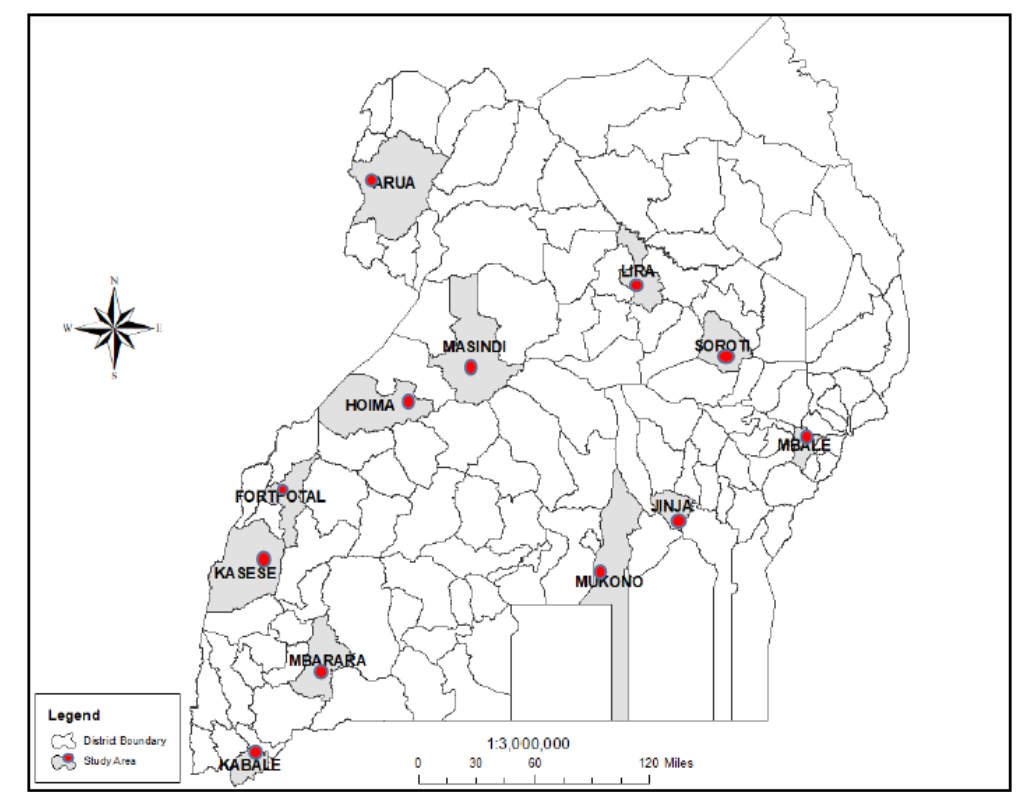
Figure 1. Location of municipalities with CDM compost plants surveyed in Uganda in June 2019.